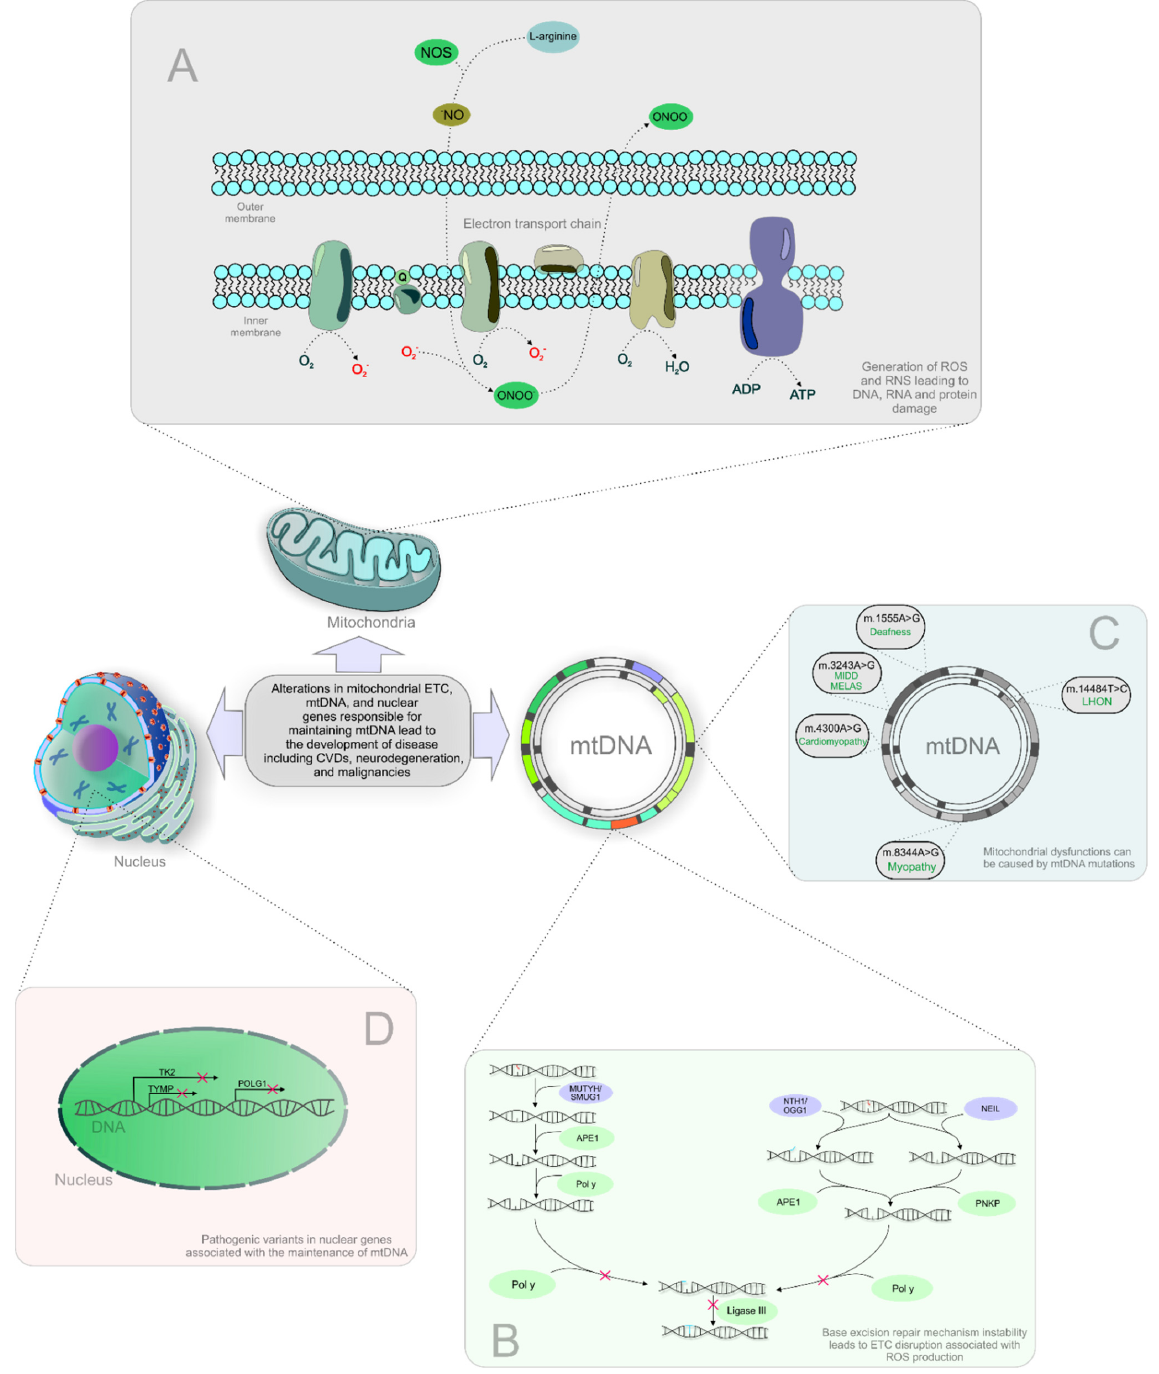
Figure 1. Processes involved in mitochondrial impairments and associated diseases. Abbreviations: ROS, reactive oxygen species; RNS, reactive nitrogen species; mtDNA, mitochondrial DNA; MELAS, mitochondrial encephalomyopathy, lactic acidosis, and strokelike episode syndrome; CPEO, chronic progressive external ophthalmoplegia; CVDs, cardiovascular diseases; NOS, nitric oxide synthase; NO, nitric oxide; ONOO, peroxynitrite; ADP, adenosine diphosphate; ATP, adenosine triphosphate; MUTYH, mutY DNA glycosylase; SMUG1, single-strand selective monofunctional uracil-DNA glycosylase; APE1, human apurinic/apyrimidinic endonuclease; POL γ , DNA polymerase subunit gamma ; NTH1, Nth like DNA glycosylase 1; OGG1, 8-oxoguanine DNA glycosylase; NEIL, human endonuclease VIII-like; PNKP, polynucleotide kinase 3’-phosphatase; O 2 , dioxygen; O 2- , ion superoxide; H 2 O, dihydrogen monoxide/water.